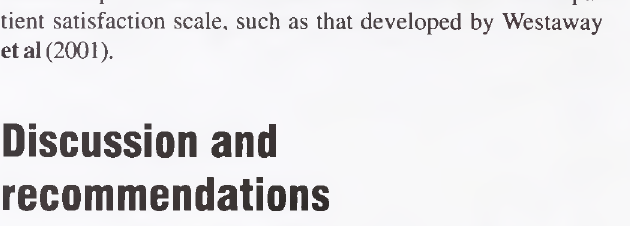
Figure 3: Pie diagram of the languages spoken by the patients interviewed